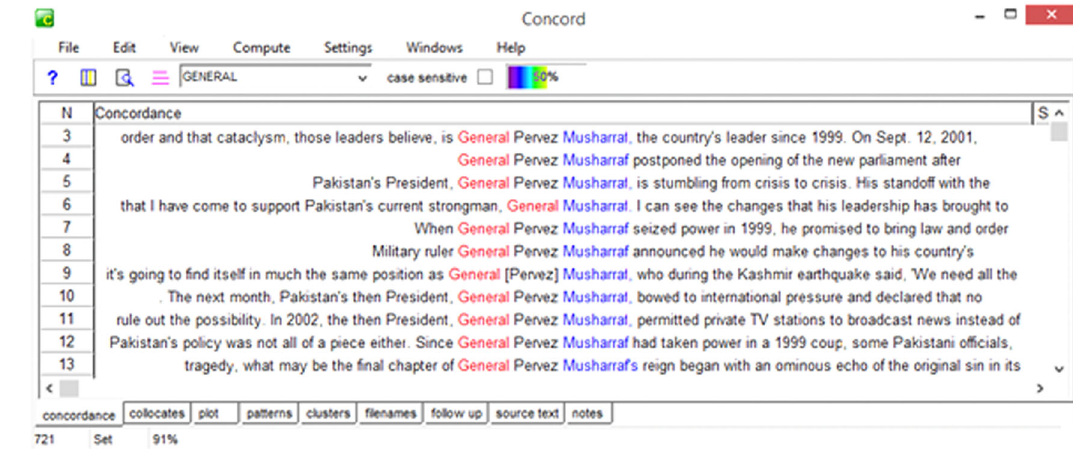
Fig. 6 Concordance extract. Concordance extract General-Musharraf* .